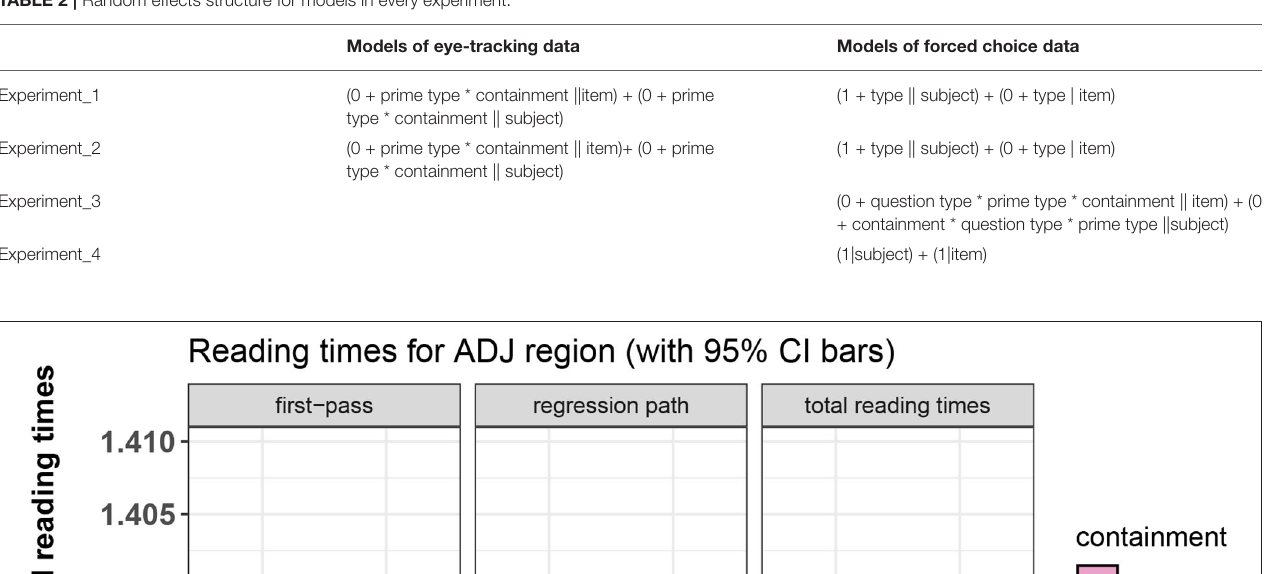
TABLE 2 | Random effects structure for models in every experiment.